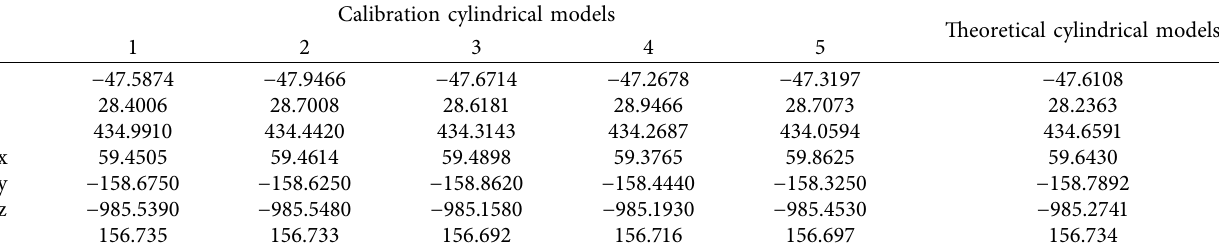
Table 2: Fit the cylindrical